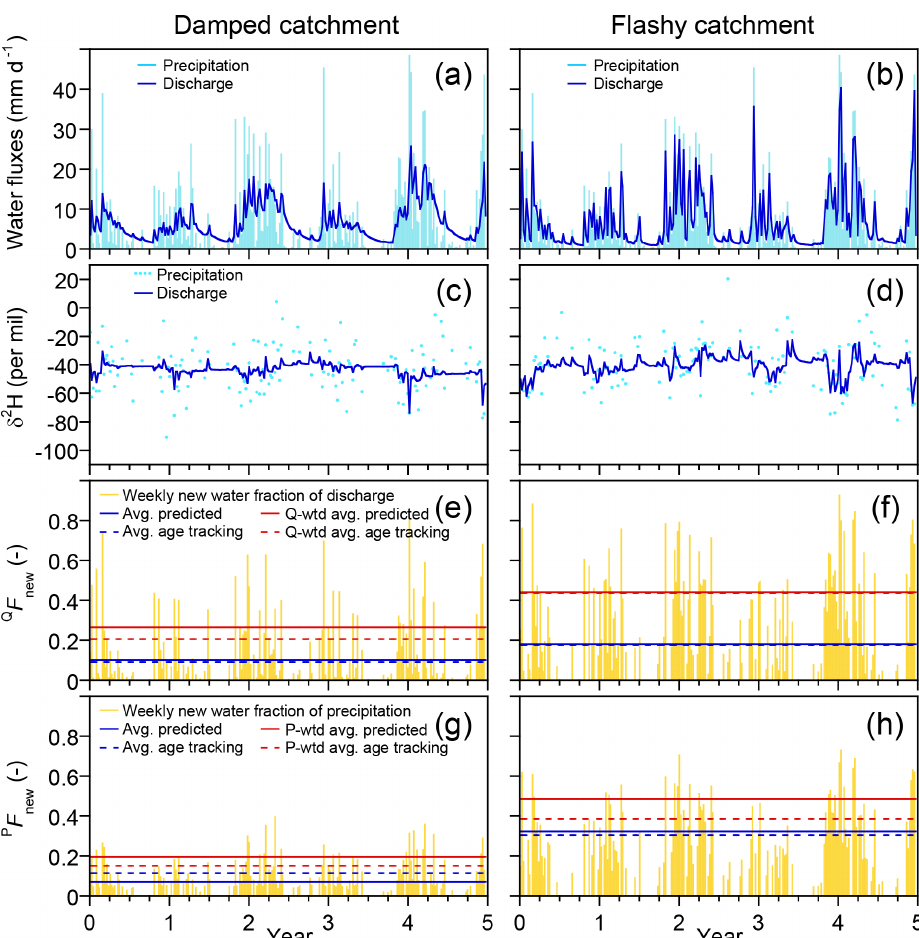
Figure 4. Illustrative simulations of weekly water fluxes, deuterium concentrations, and new water fractions. The benchmark model, pre- cipitation forcing, and parameter values are identical to those in Fig. 1. Although the isotope tracer concentrations and new water fractions exhibit complex nonstationary dynamics, ensemble hydrograph separation yields reasonable estimates of the average backward and forward weekly new water fractions, as shown in (e, f) and (g, h) , respectively. Panels (a) and (b) show weekly average rates of precipitation and discharge. Panels (c) and (d) show the weekly volume-weighted isotopic composition of precipitation (mimicking what would be collected in a weekly rain sample) and the instantaneous composition of discharge at the end of each week (mimicking what would be collected in a weekly grab sample). Panels (e) and (f) show the fraction of discharge that is composed of same-week precipitation (the weekly new water fraction; yellow lines), as determined from model age tracking, and its long-term average (dashed blue line), compared to the new water fraction predicted by ensemble hydrograph separation (solid blue line) from the weekly samples shown in (b) . Panels (g) and (h) show the fraction of precipitation that becomes same-week discharge (the weekly new water fraction of precipitation, or forward new water fraction, yellow lines), as determined from model age tracking, and its long-term average (dashed blue line), compared to the new water fraction predicted by ensemble hydrograph separation (solid blue line). Discharge-weighted and precipitation-weighted average new water fractions, and their predicted values, are shown by red solid and dashed